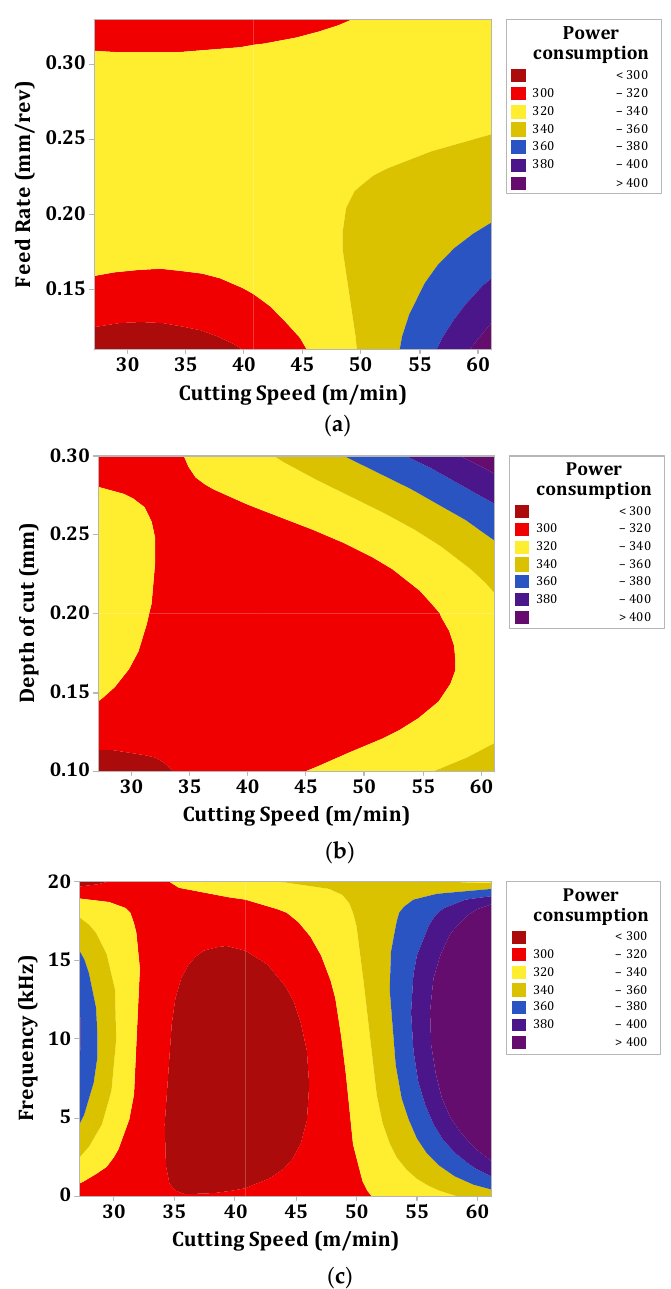
Figure 6. Influence of machining parameters on power consumption values ( a ) Feed rate vs. cutting